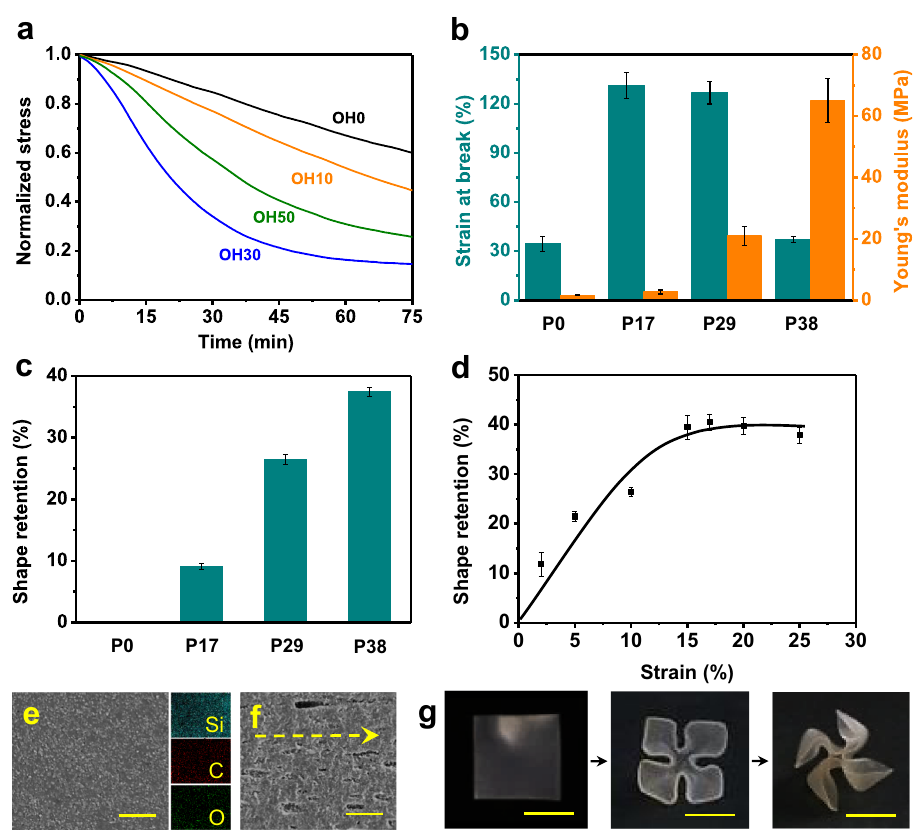
Fig. 2 Characterizations of the silica-polymer nanocomposites. a Isostrain stress relaxation of the neat polymer networks at 130 °C (strain is fi xed at 10%). b Mechanical properties of composites with different contents of SiO 2 nanoparticles. c Shape retention of the composites measured for an initial strain of 10%. d The impact of strain on the shape retention for P29. e Scanning electron microscopic (SEM) image (left) and energy dispersive X-ray spectrometry (EDS) mapping (right) of the composite surface. Scale bar: 2 μ m. f SEM image of the composite surface after stretching by 100%, with the arrow showing the stretching direction. Scale bar: 2 μ m. g Multi-step accumulative shape recon fi guration of the composite, with each step occurring at 130 °C for 2 h. Scale bars: 1 cm. All error bars represent standard